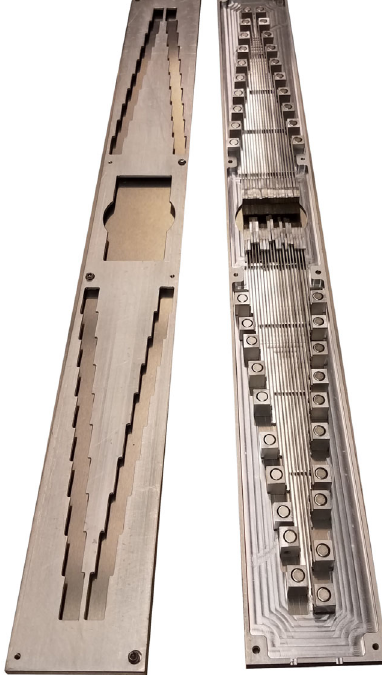
FIG. 4. Photograph of the MLC endoskeleton. 40 leaves are installed. The left half is attached on top of the right half to form the cassette for insertion into the vacuum chamber.